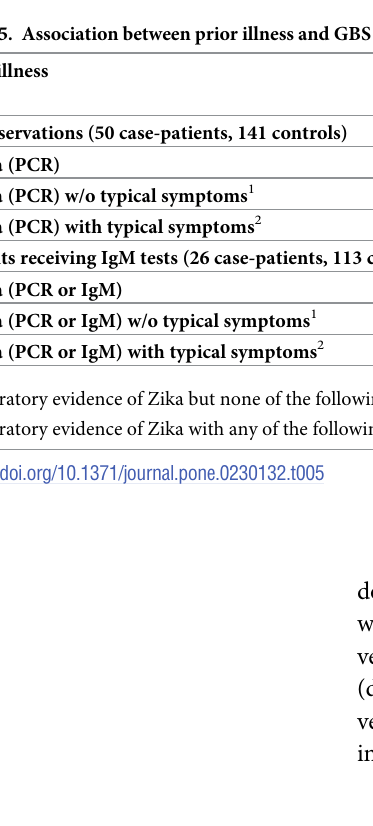
Table 6. Neurological signs and symptoms at onset or nadir of GBS case-patients: n (%). Neurological signs and symptoms All (n = 50) Zika diagnosis by PCR or IgM (n = 26)